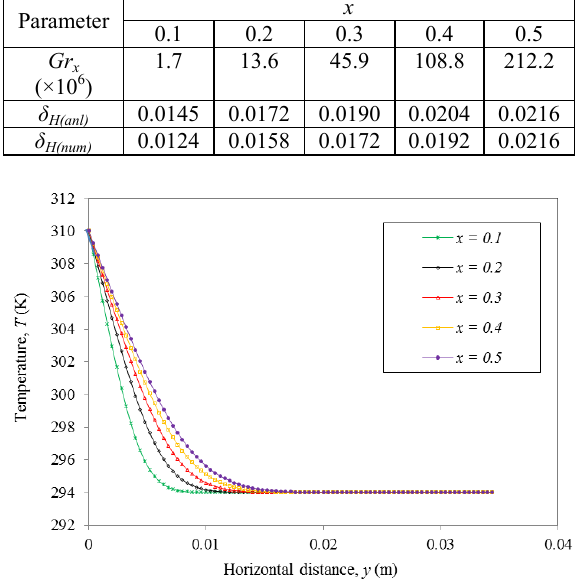
Figure 7. Temperature profiles for methane in the vertical direction at various locations along with the heated vertical cylinder